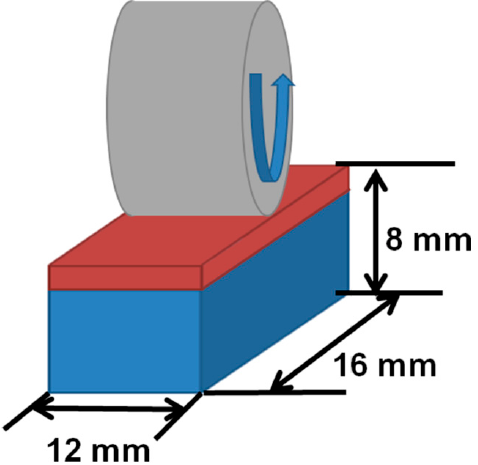
Figure 1. Illustration of the wear tests.